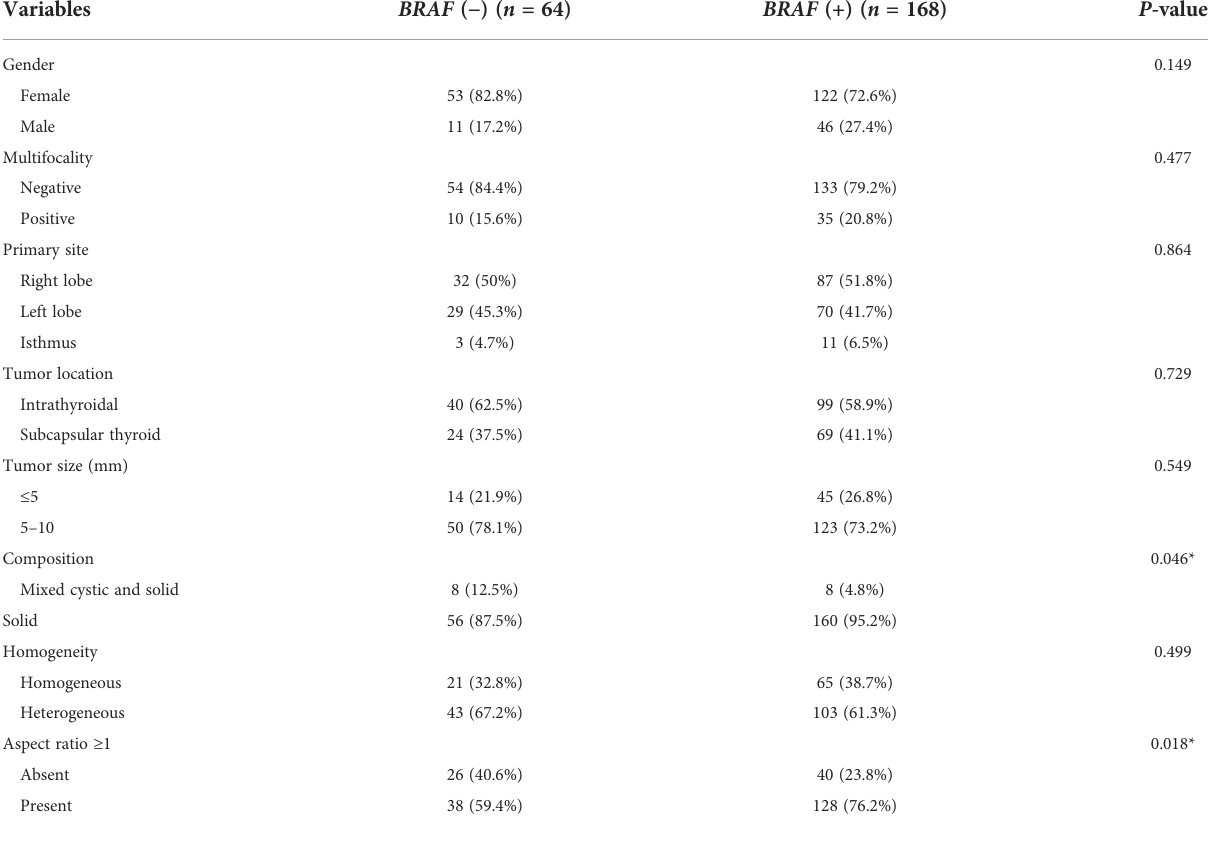
TABLE 2 Demographic and sonographic characteristics of PTMC patients by BRAF mutation status in the training cohort ( n =